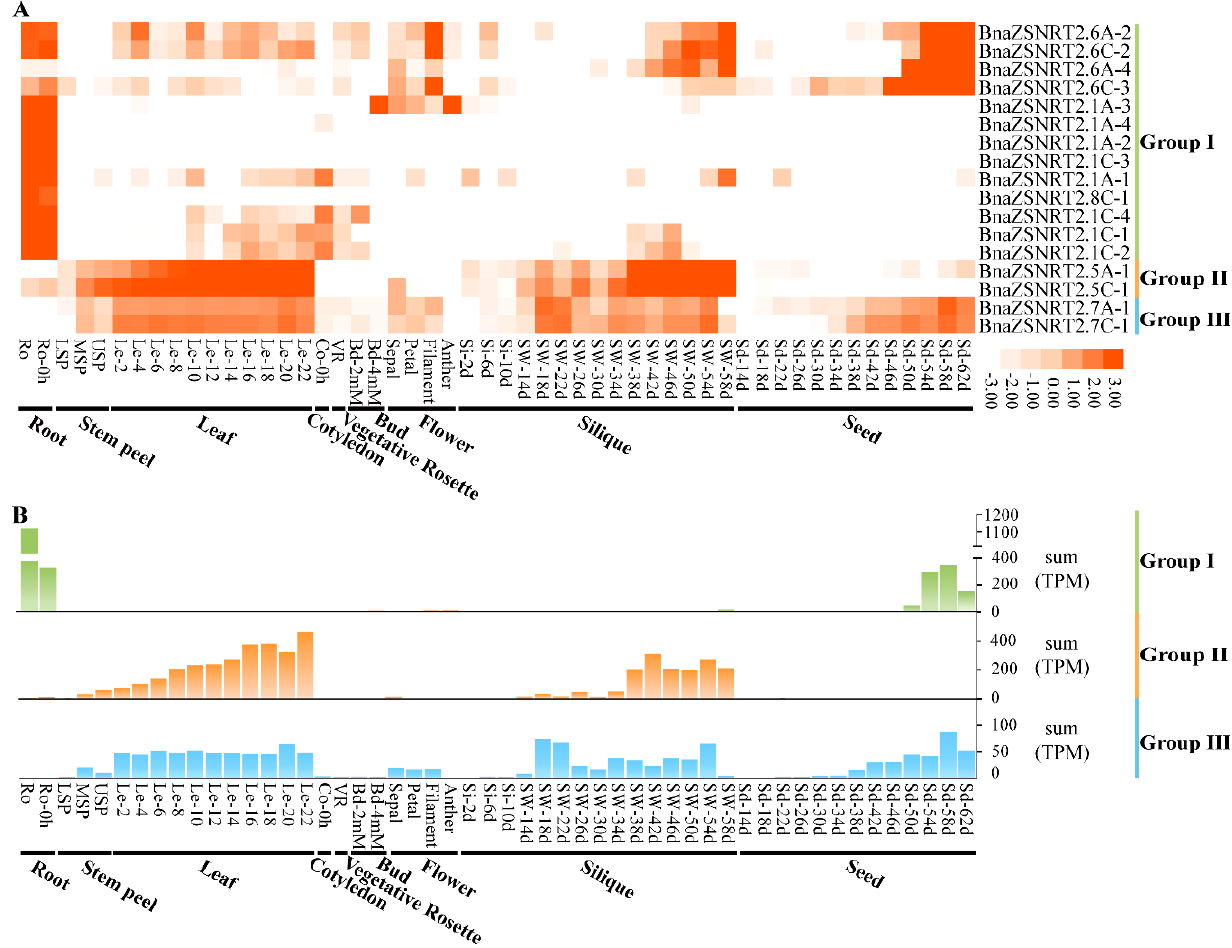
Figure 5. Expression pattern of BnaZSNRT2s in B. napus at different developmental stages. ( A ) The expression profile of BnaZSNRT2s in 52 tissues. ( B ) The sum of expression levels in Group I − III. The ordinate represents the sum of expression levels (TPM). “Ro” = root, “LSP” = lower stem peel, “MSP” = middle stem peel, “USP” = upper stem peel, “Le” = leaf, “Co” = cotyledon, “VR” = vegetative rosette, “Bd” = bud, “Si” = silique, “SW” = silique wall, “Sd” = seed; “h,” and “d,” indicate hour and day,